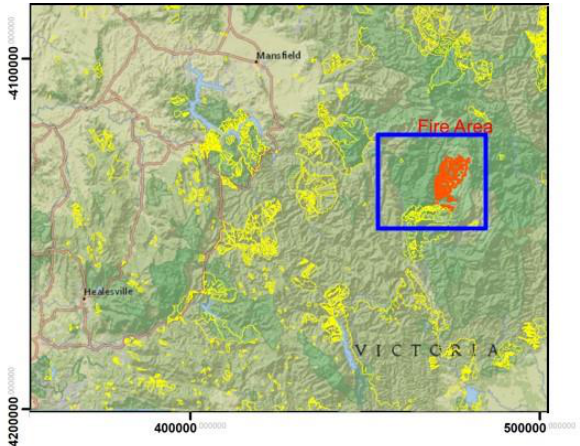
Figure 2. Bushfires and controlled burns between 2015 and 2020 (in yellow), from the Victoria bushfire database. In red: fires selected for this study in period 2019/2020. Map source: National Geographic, Esri, Garmin, HERE, UNEP-WCMC, USGS, NASA, ESA, METI, NRCAN, GEBCO, NOAA, increment P Corp. The study area is indicated in blue.